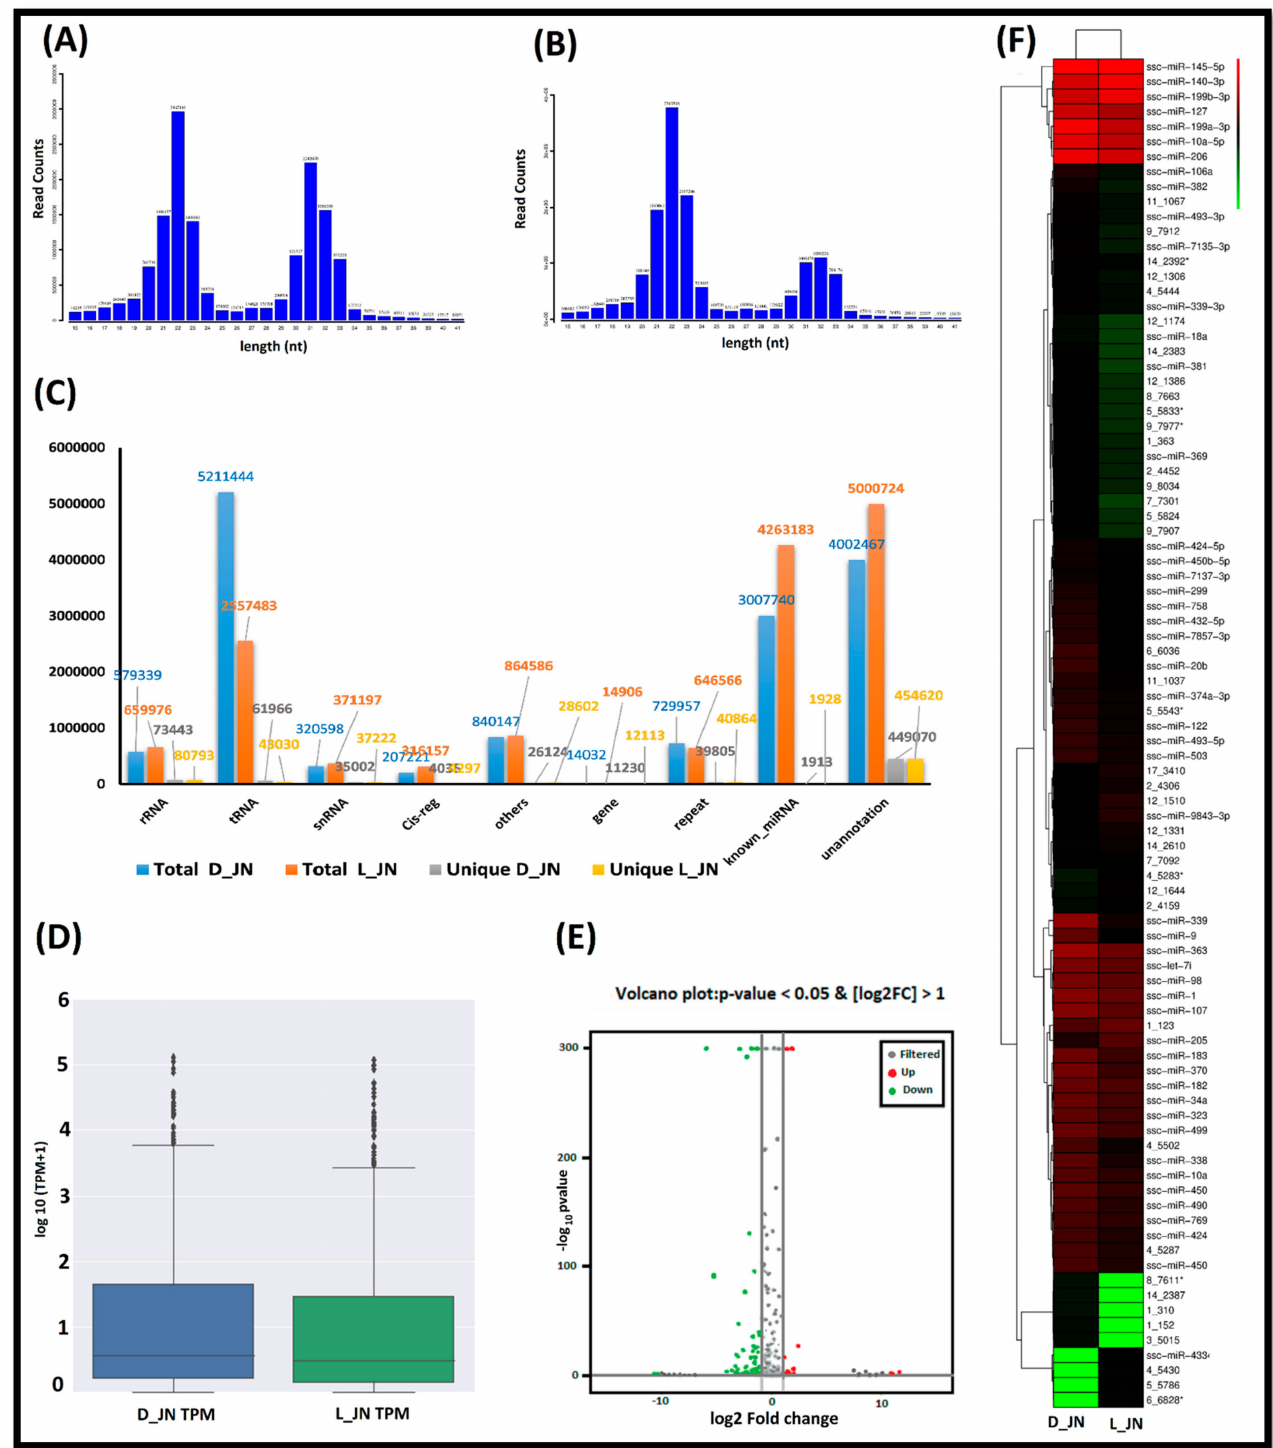
Figure 2. Statistics of miRNA in two contrasting pig samples; ( A ) length count of miRNAs in the D_JN pig; ( B ) length count of miRNAs in L_JN. ( C ) Comparison of various small non-coding RNAs in two pig breed samples. ( D ) Box plot generation analyzes the symmetry of miRNA data in L_JN and D_JN. ( E ) Volcano plot representing DEmiRNAs in the IMF tissue of L_JN and D_JN. The red dots and green dots represent the upregulated and downregulated miRNAs in IMF tissue, respectively. ( F ) Heat map of DEmiRNAs presenting their expression patterns in two pig samples between two color peaks (red represents upregulated and green portrays downregulated